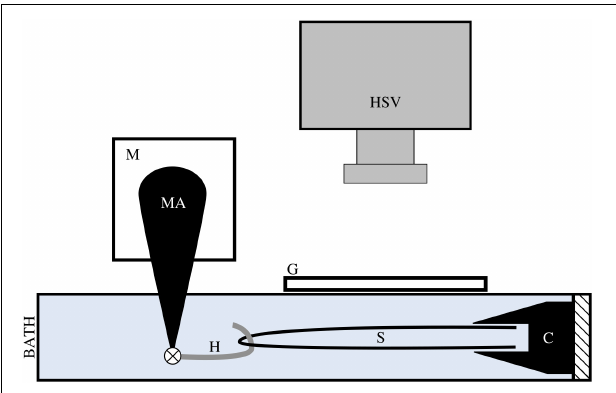
FIGURE 2 | We applied tensile stress to a tendon fascicle sample (s) via a muscle motor (m) while recording video of the sample at 1000 Hz with a high speed video camera (HSV). We formed a loop with the tendon fascicle, gripped the two free ends in a clamp (c), and connected a hook (h) through the fascicle sample loop. The hook, which attached to the motor arm (MA) via a pin joint, was lined with plastic tubing to reduce friction on the sample during testing. During testing, the hook, fascicle, and clamp were fully submerged in mammalian Ringer’s solution. To prevent ripples at the surface of the solution, we placed a glass slide (g) directly above the fascicle